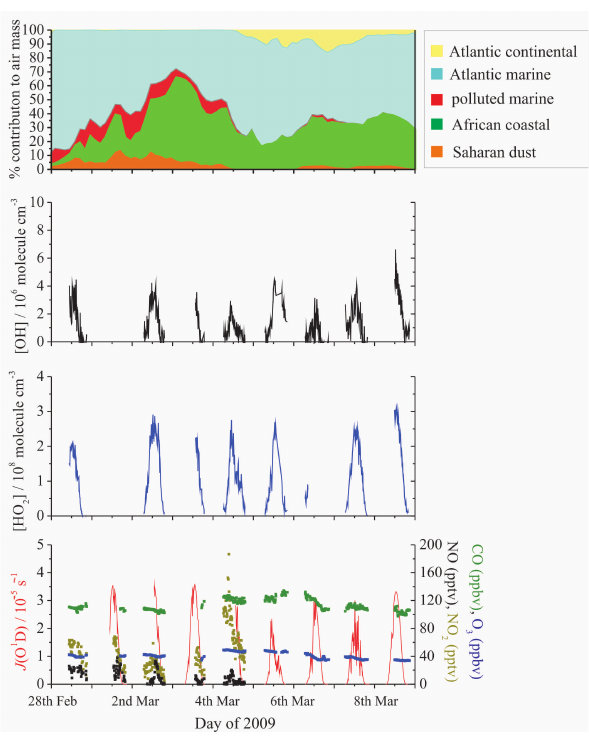
Fig. 3. Time-series of OH, HO 2 and supporting measurements for SOS1. Top panel: source-region percentage contributions to air mass from Atlantic continental (yellow area), Atlantic marine (blue area), polluted marine (red area), African coastal (green area) and Saharan dust (brown area). Middle panels: observed concentrations of OH (five-minute average) and HO 2 (four-minute average). Bot- tom panel: five-minute averaged J (O 1 D) (red line), and the average mixing ratios of CO (green dots), O 3 (blue dots), NO (black dots) and NO 2 (dark yellow dots); for clarity only the supporting data that are simultaneous with HO x -measurements are shown.